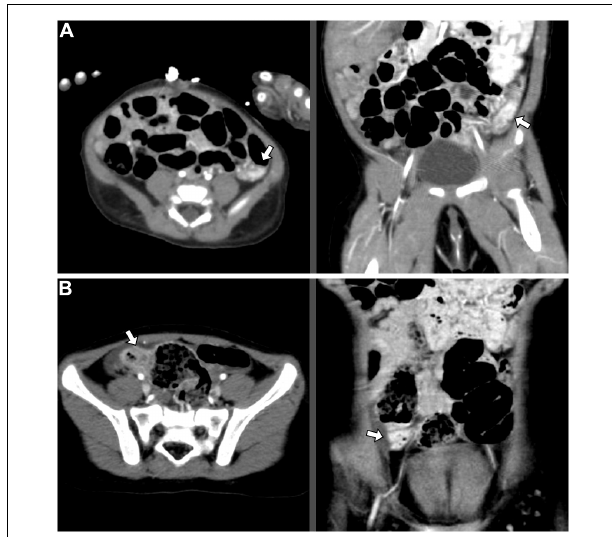
FIGURE 2 | Abdominal CT angiography images indicating corresponding locations of the AD, axial (left) and coronal (right) view: (A) Case 2: Wall enhancement of focal segments at the left lower abdomen, suspected of hemangioma or hypervascular lesions in the descending colon (white arrow); (B) Case 3: Focal increased wall enhancement at the ascending colon (white arrow). AD, angiodysplasia; CT, computed